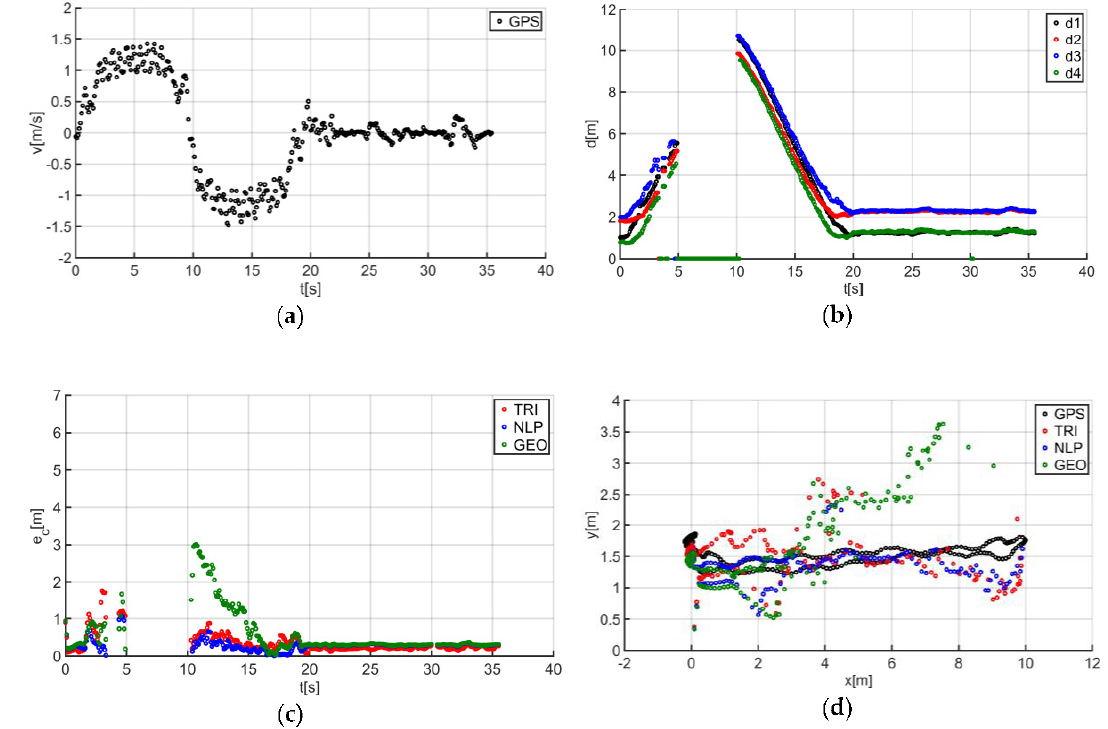
Figure 20. Test results no. 7: ( a ) human guide speed v p (t) and ( b ) filtered distance from anchors d i (t), i = 1, 2, 3, 4; ( c ) course of total location errors e c (t) and ( d ) location of the human guide y p (t) = f(x p (t)).